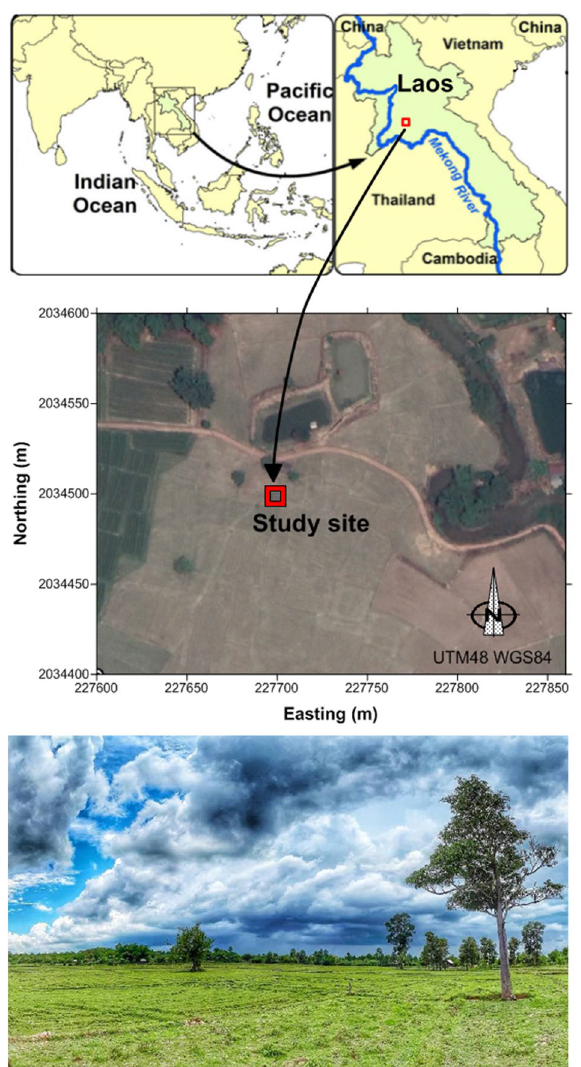
Figure 1. Study site: ( a ) location of the site in northern Laos; ( b ) situation within the cultivated plain of the Nabone village (Satellite image 2019-02-22, Image © 2021 Maxar Technologies, Google Earth); ( c ) photograph of the paddy rice field where the soil profile was observed, monitored, and sampled. This figure was created using Surfer ® 11 (Golden Software